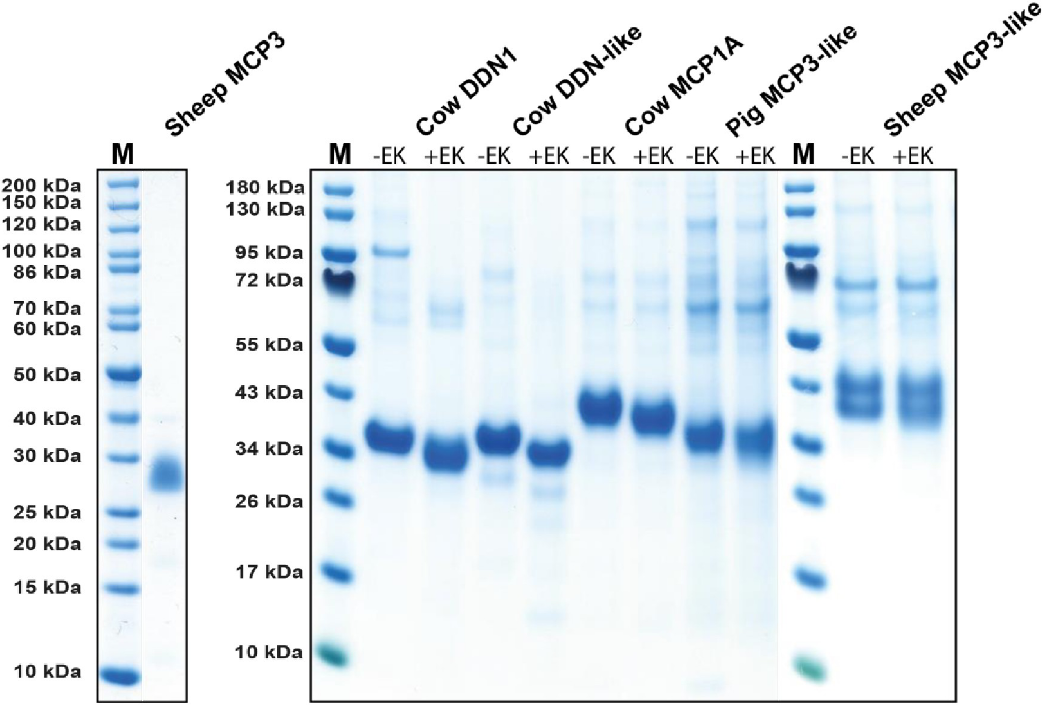
Fig 4. SDS-PAGE of the recombinant sheep, cow and pig duodenases. The recombinant sheep MCP3 was expressed in a baculovirus expression system. These proenzymes were first purified on Ni-NTA beads (-EK) and then activated by removal of the His 6 -tag by enterokinase digestion (+EK). Following activation, the enzyme was further purified over heparin-Sepharose columns. In the right part of the figure we show the recombinant cow, pig and sheep duodenases, cow DDN1, cow DDN-like, cow MCP1A, Pig MCP3-like and the second sheep duodenase sheep MCP3-like. All these proteases were produced in the human cell line HEK293-EBNA using the episomal vector pCEP-Pu2. After purification on IMAC columns they were activated by enterokinase cleavage. The proteins are shown before and after enterokinase cleavage. Enterokinase removes the N terminal six his tag and the enterokinase site resulting in a reduction in size of the protein by approximately 1.5 kDa. The enzymes were after purification analysed by separation on SDS-PAGE and visualized with Coomassie Brilliant Blue staining.